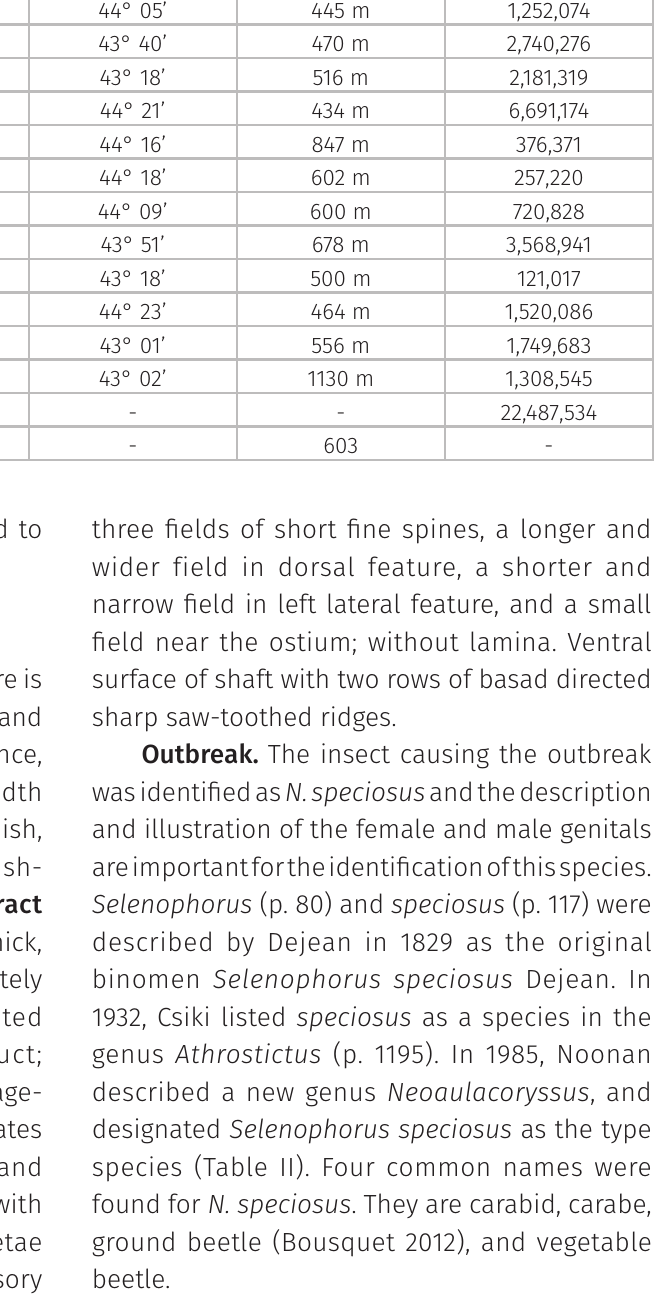
Table I. South latitude, West longitude, altitude, and area (Km2)* of 12 municipalities of the northern region of Minas Gerais State, Brazil with recorded occurrence of Neoaulacoryssus speciosus (Coleoptera: Carabidae).